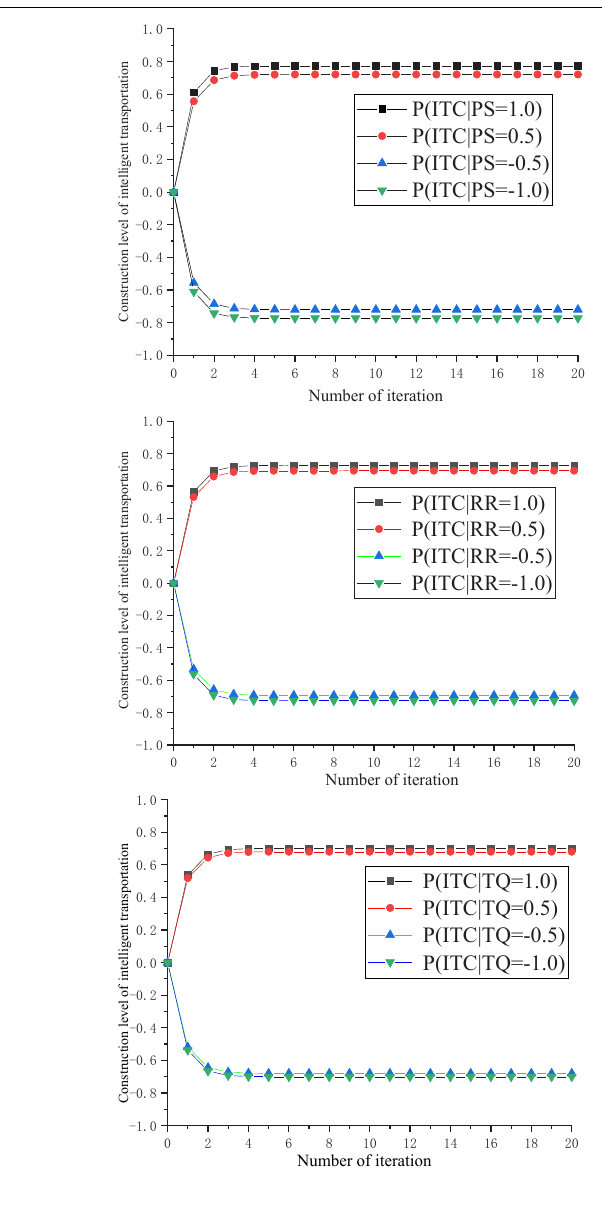
of which 188 were valid (valid response rate was 36.29%).